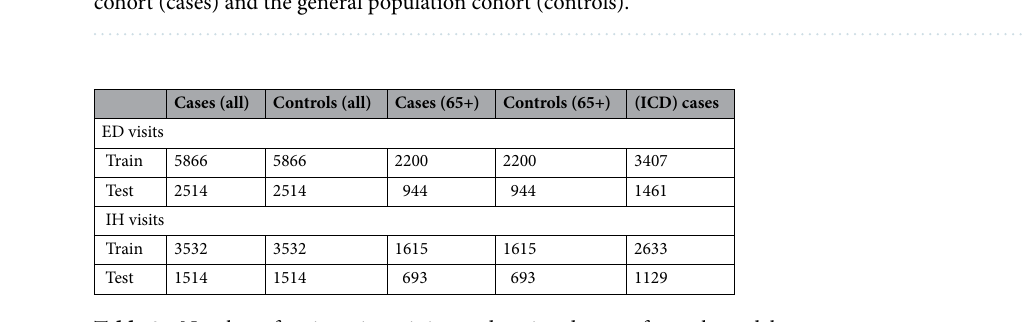
Table 3. Number of patients in training and testing datasets for each